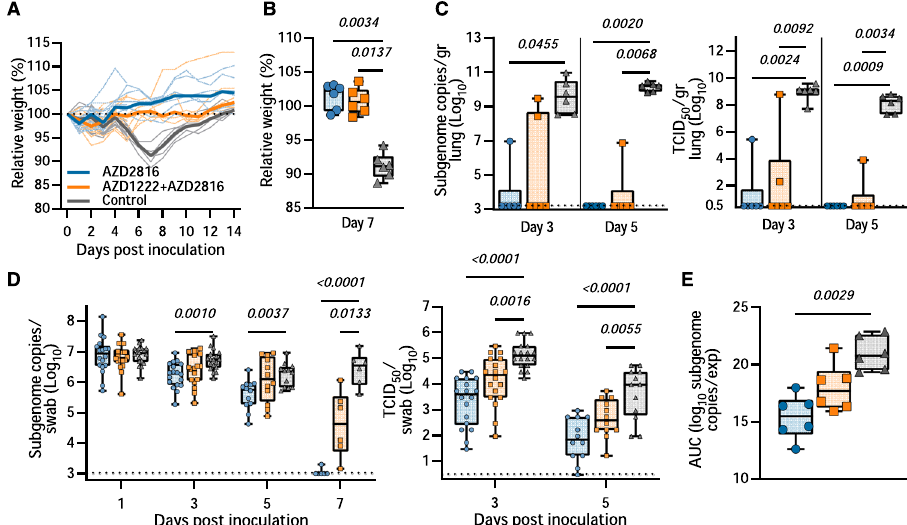
Fig. 2 | Vaccination of Syrian hamsters with AZD2816 or AZD1222 followed by AZD2816 reduces lower respiratory tract infection by the Beta VoC. Twenty- eight days post fi nal vaccination, hamsters were challenged with 10 4 TCID 50 of the Beta variant, via the intranasal route. A Relative weight in comparison to day 0. Thick lines=median weight per group, thin lines=individual animals, dotted line=100% relative weight. Days 0 – 3 N =18, Days 4 – 5, N =12, Days 6 – 14 N =6. B Boxplot (minimum to maximum) of relative weight at day 7. Statistical sig- ni fi cance was determined via a Kruskall-Wallis test followed by Dunn ’ s multiple comparisons test. C Boxplot (minimum to maximum) of subgenomic SARS-CoV-2 RNA (sgRNA) (left panel) and infectious virus isolation (right panel) in lung tissue harvested on day 3 and 5 ( N =6). Statistical signi fi cance was determined via a Kruskall Wallis test followed by Dunn ’ s multiple comparisons test. Dotted line= limit of detection. D Boxplot (minimum to maximum) of sgRNA (left panel) and